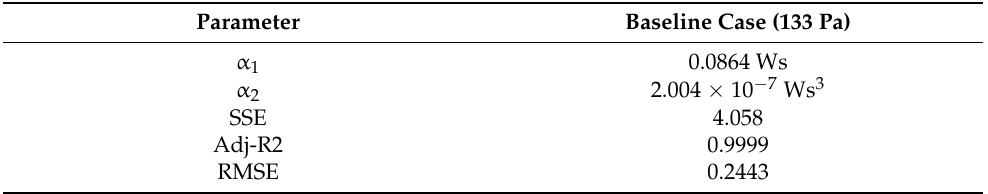
Table 5. Best fit coefficients for the electrical machine passive discharge approximation along with goodness of fit statistical parameters (SSE: error sum of squares, Adj-R2: adjusted R-squared, RMSE: root-mean-squared